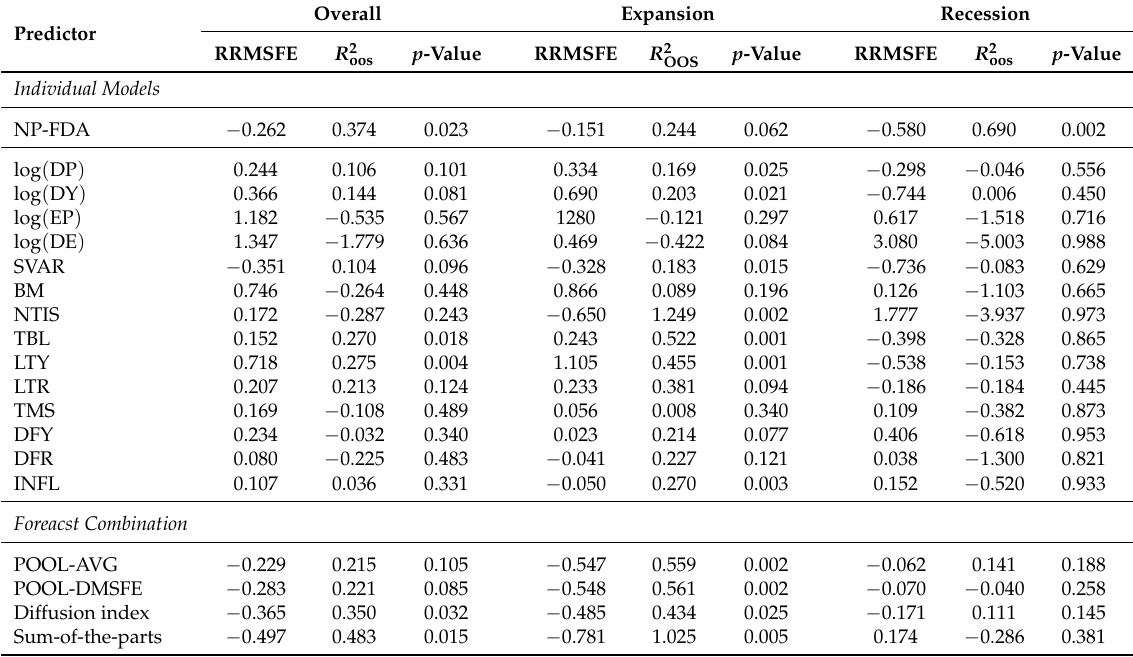
Table 1. Out of sample forecasting evaluation of S&P500 excess return based on nonparametric functional data analysis (NP-FDA) and regression